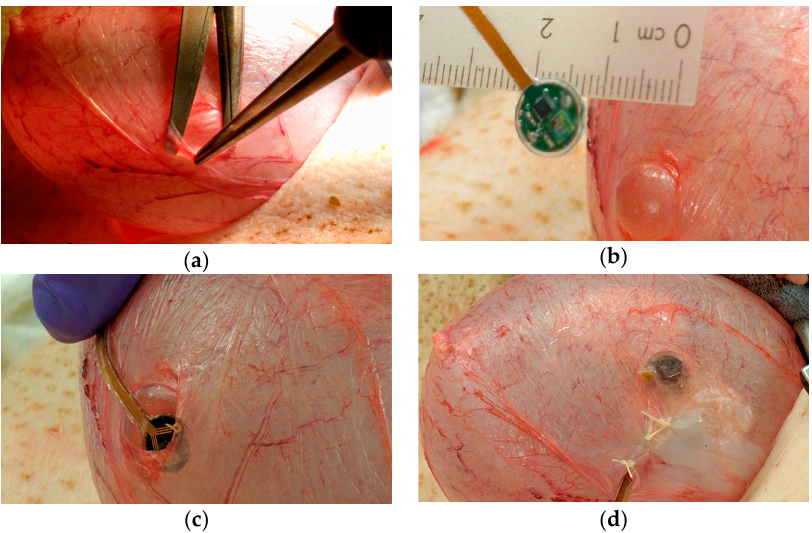
Figure 2. Submucosal insertion of the device in a pig bladder. ( a ) An incision is made in the detrusor